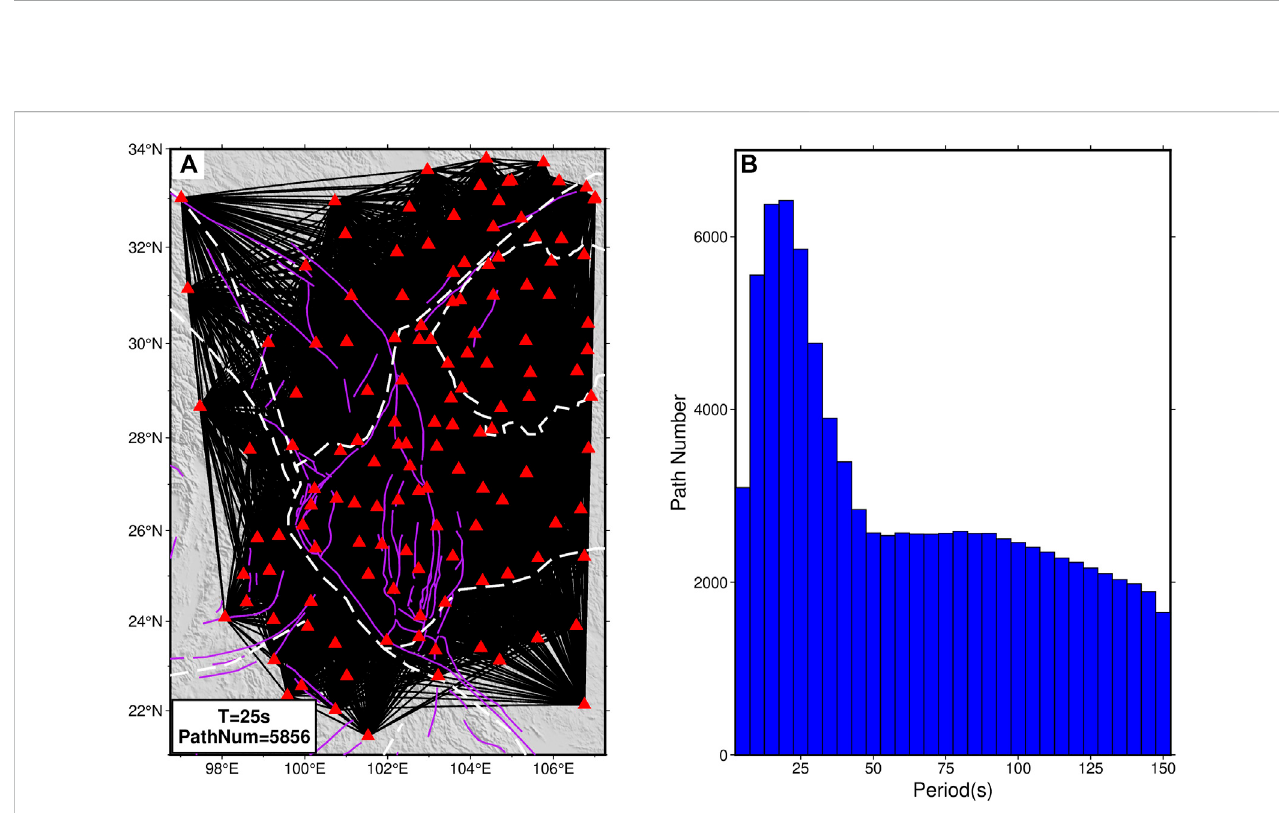
FIGURE 2 (A) Path coverage at a period of 25 s. The red triangles represent stations. “ T ” is the period, and “ PathNum ” is the path number at the corresponding period. (B) Number of paths of each period.